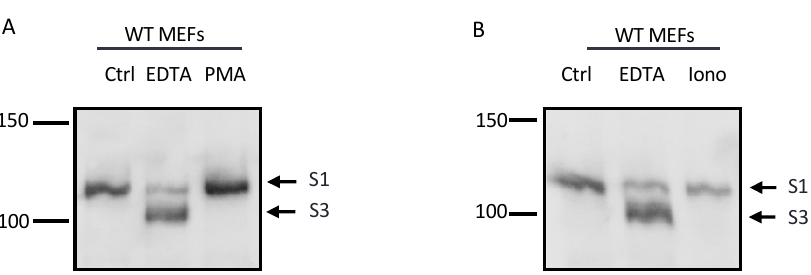
Figure 4. Processing of the endogenous S2 site cannot be induced by the stimulation of ADAM10 or ADAM17. ( A ) WT mEFs were treated with 25 ng/mL of PMA, a strong activator of ADAM17, or ( B ) with 2.5 µM ionomycin, which strongly activates both ADAM10 and 17, with 5 mM EDTA treatment for 30 min included as a positive control for the processing of Notch1. The Western blots shown are representative of at least 3 independent experiments.